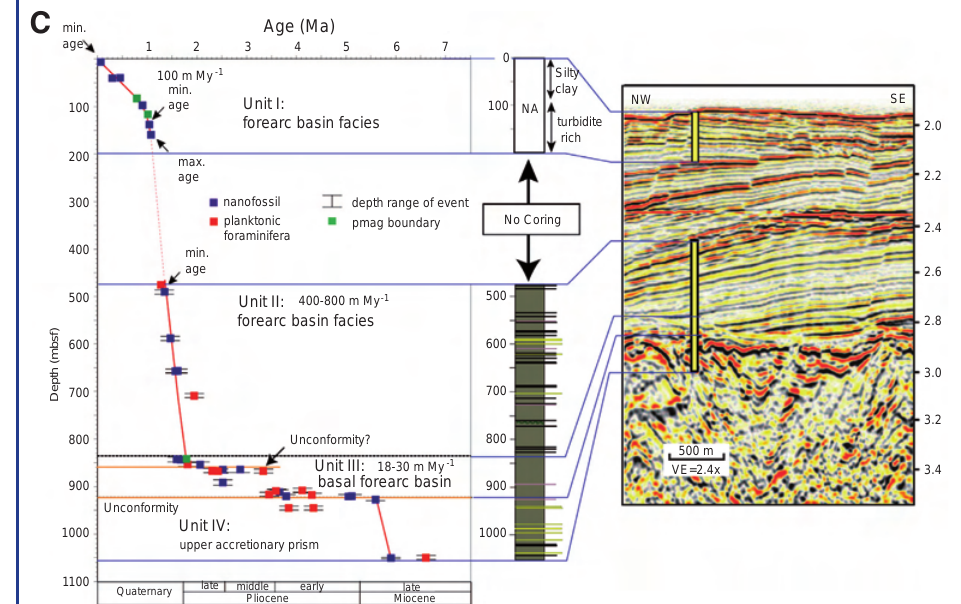
Figure 8 [C]. Site C0002 – Biostratigraphic age determinations for the cored intervals, illustrating contrast between prism, slope drape, and forearc basin sediment accumulation timing and rates.